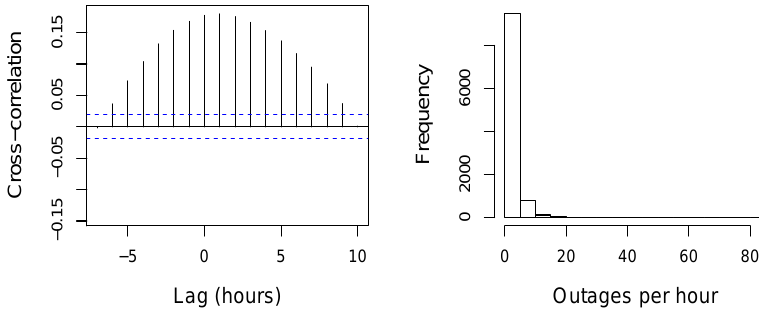
Figure 1. Cross-correlation of wind speed, averaged at each hour across town centroids, and customer-reported outages ( left ); horizontal dashed lines indicate the threshold for statistical significance, which is the 95 percent confidence interval when the underlying true correlation values are zero. Histogram of outages per hour across the study period ( right